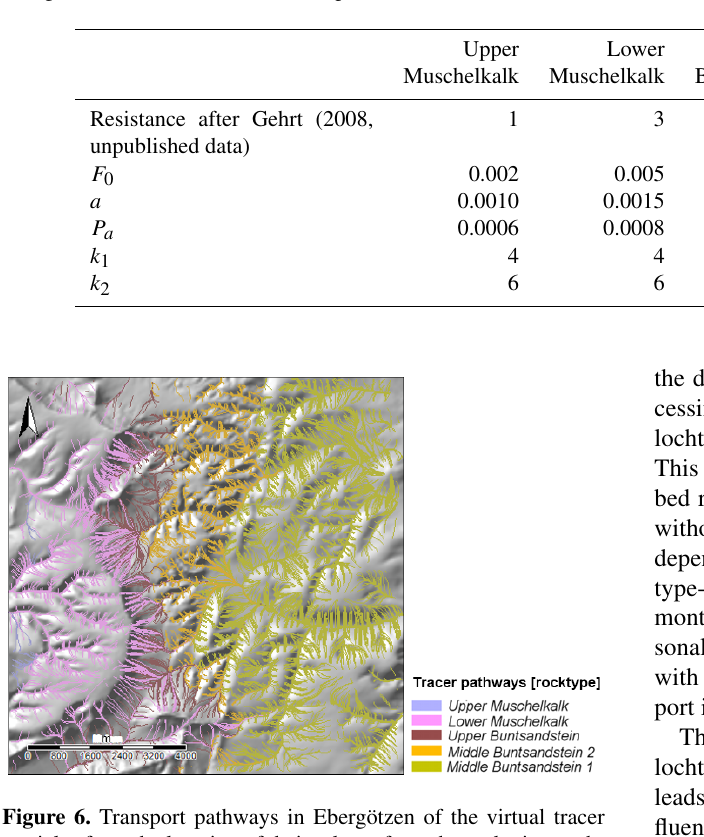
Table 1. Resistance against weathering (frost weathering and chemical weathering) of different triassic bedrock types occurring at the Ebergötzen site after Gehrt (2008, unpublished data) and derived initial values for the parameters of SaLEM’s weathering (Eqs. 1 and 2).